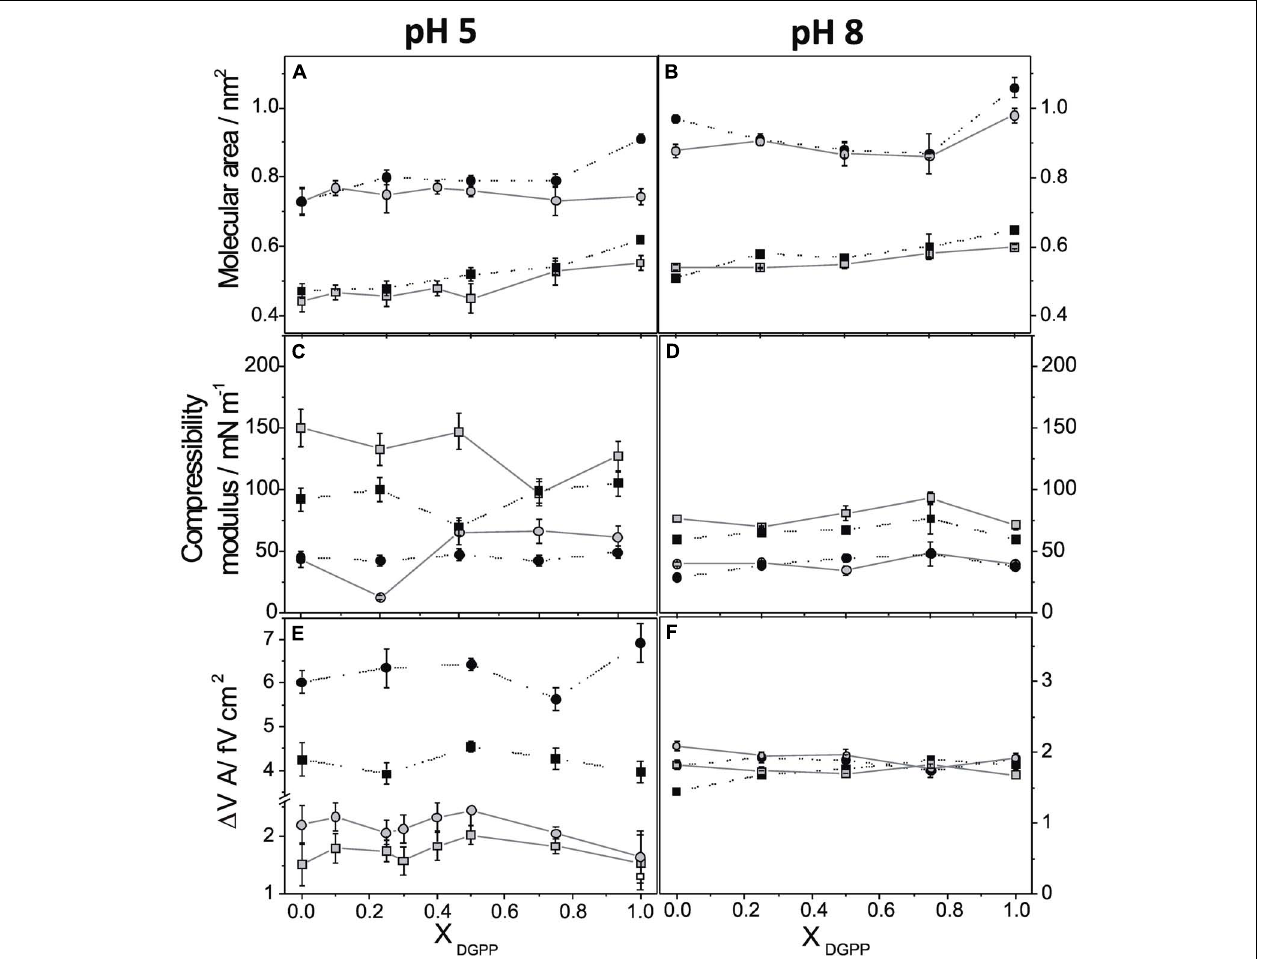
FIGURE 4 | Mean molecular area (A,B), compressibility modulus (C,D), and surface potential density (E,F) as a function of the mole fraction of DGPP in the mixture at pH 5 (left panel) and pH 8 (right panel). The lateral